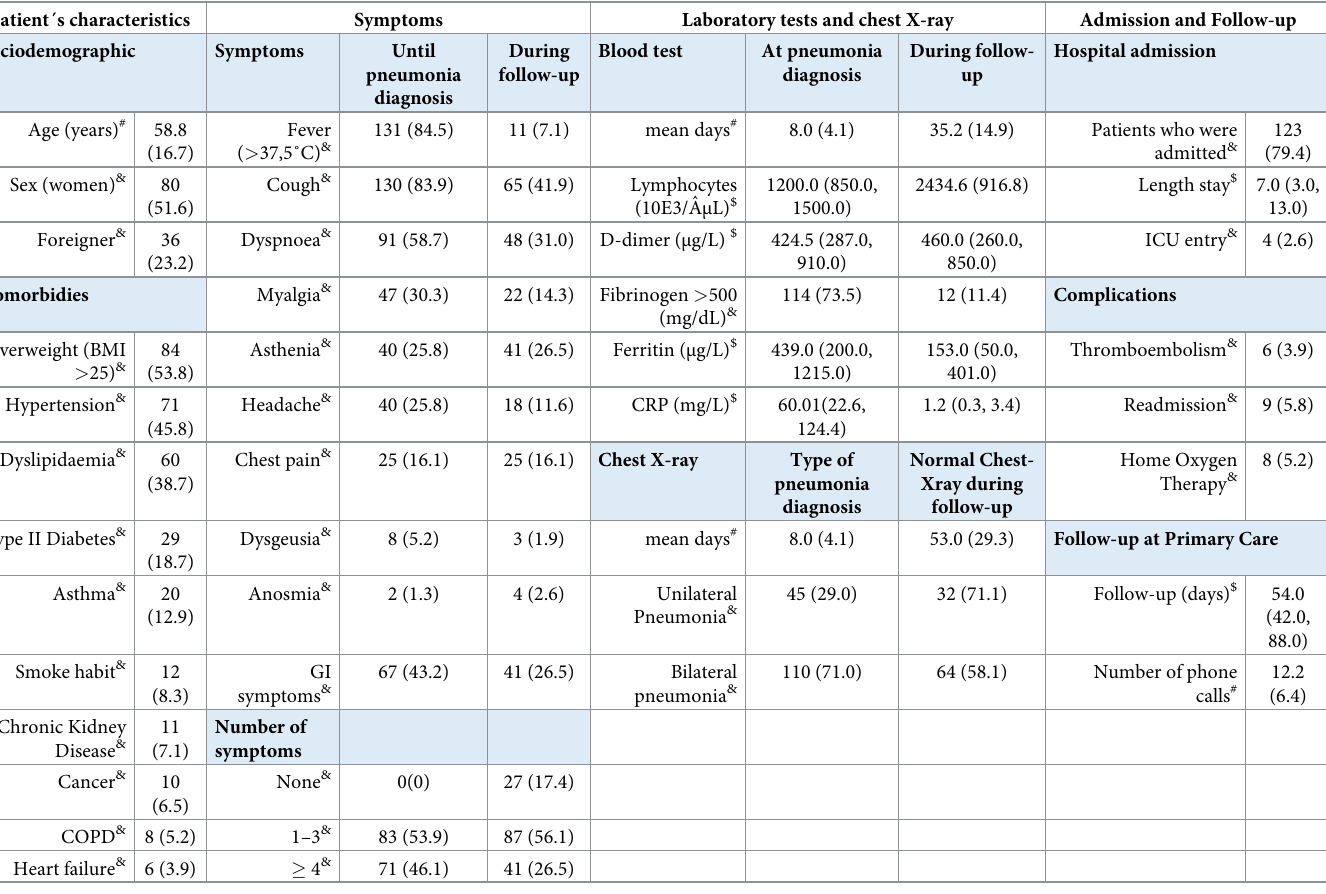
Table 1. SARS-CoV-2 pneumonia patient’s characteristics (N = 155) followed by primary care in 2020 from onset to recovery (6